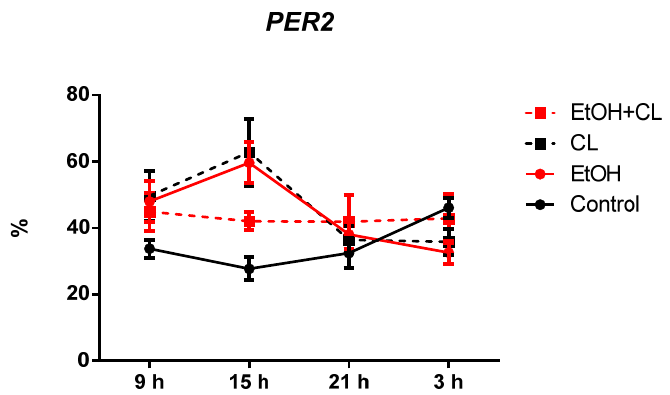
Figure 19. Daily dynamics of PER2 expression in hepatocytes of rats.